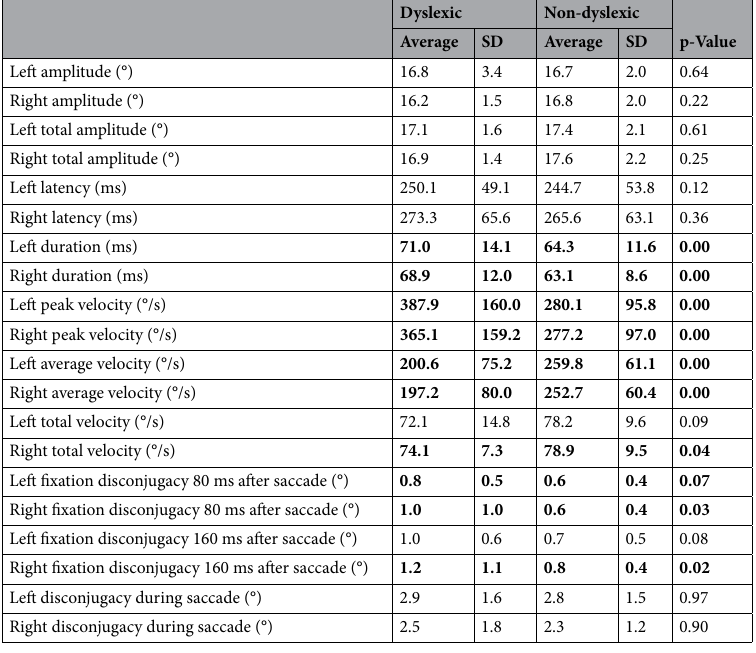
Table 2. Saccadic parameters in dyslexic and non-dyslexic adolescents. Variables with significant differences between the two populations (p < 0.05) are bolded.